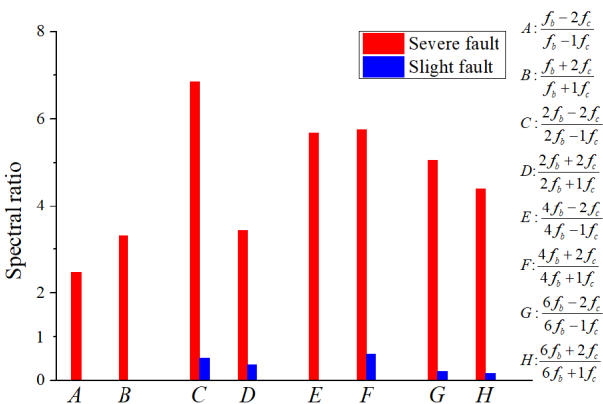
Figure 41. Acceleration envelope spectrum (severe friction).